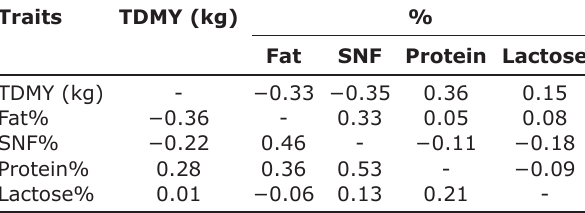
Table-3: Correlation coefficients between milk yield and composition traits at day 15 (above diagonal) and day 60 postpartum (below diagonal) in Mehsani